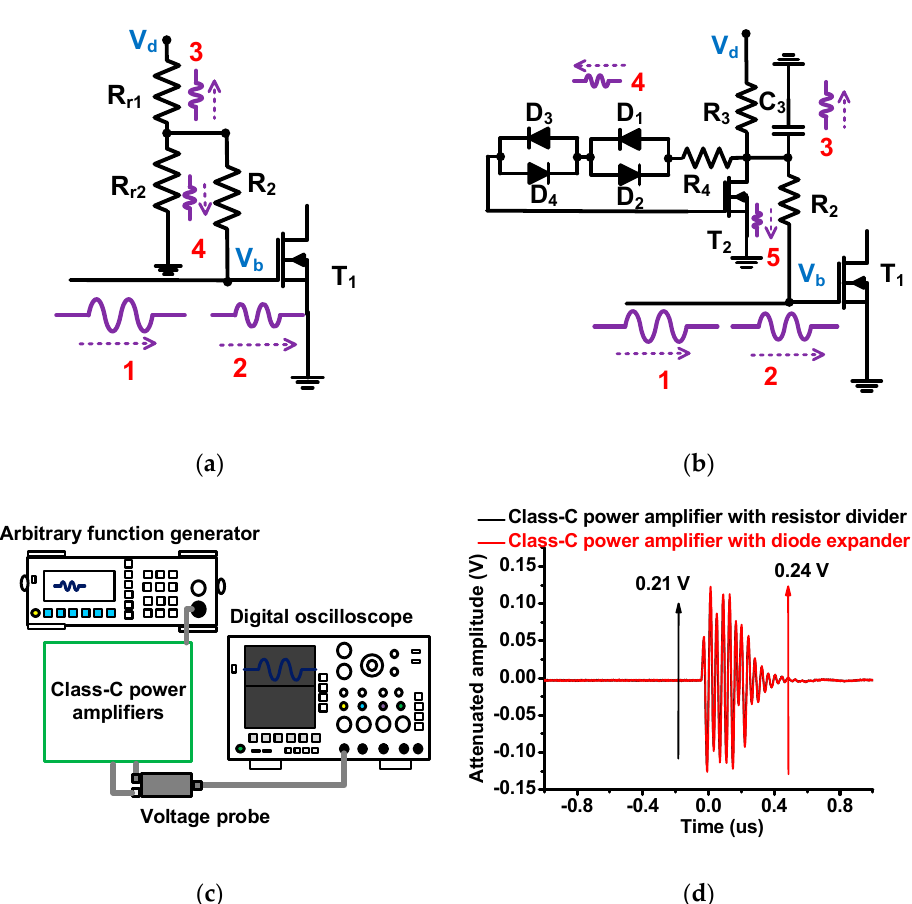
Figure 4. The AC operating mechanisms of the ( a ) resistor divider and ( b ) diode expander architecture; ( c ) measurement setup for input voltage attenuation in the class-C power amplifier; and the ( d ) measured AC input voltages at the gate of the LDMOSFET T 1 .